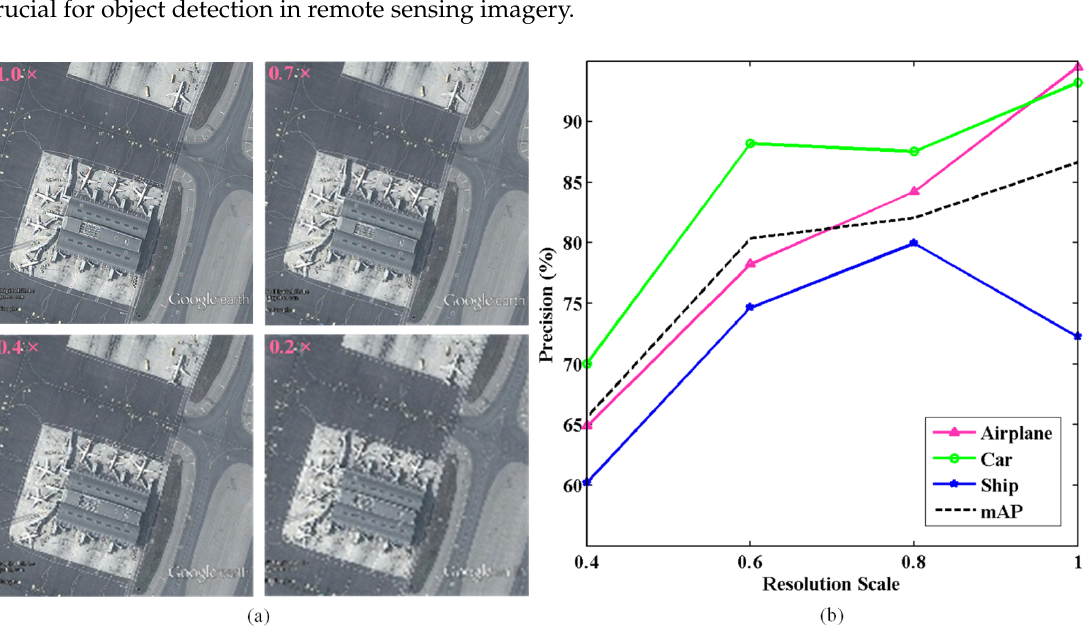
Figure 13. Subjective and objective effect. In ( a ), objects in a remote sensing image become more and more blurred as the resolution of the image decreases. In ( b ), AP and mAP curves (IoU = 0.5) of 3 categories as red, green and blue line for airplane, car and ship. As shown, AP and mAP rise with the increase in image